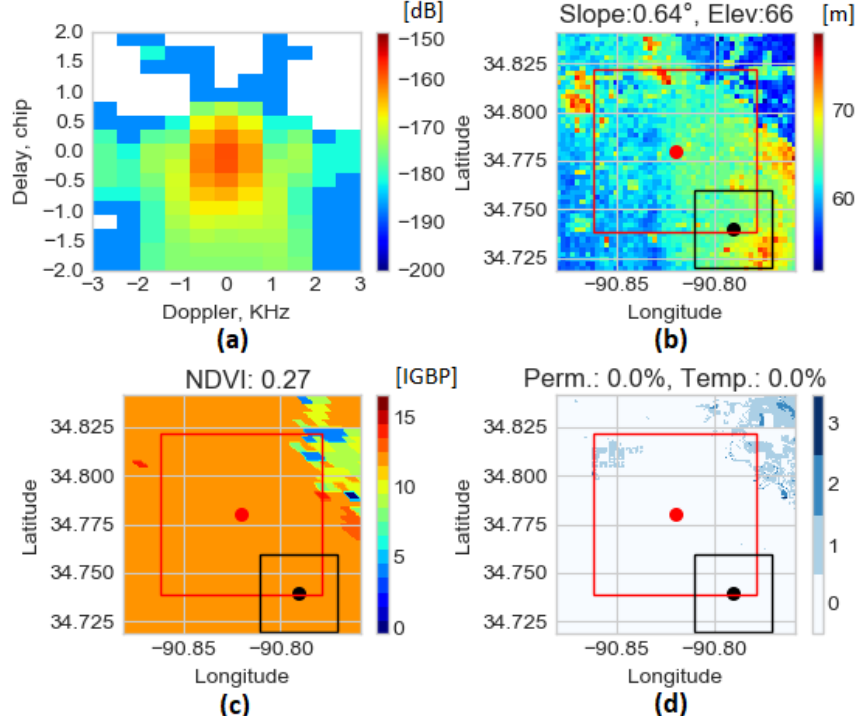
Figure 4. Example grid analysis from a CYGNSS observation over the SCAN site Uapb-Marianna on day-of year (DOY) 71, 2018. The red square is the 9-km grid cell that centers the ISMN site (red dot). The black square is the 4-km grid cells that center the CYGNSS observation SP (black dot) that could fall into anywhere in the 9-km grid. ( a ) DDM power_analog ; ( b ) digital elevation model [m]. Mean slope and elevation values calculated from 4-km grid are also shown; ( c ) IGBP land covers [IGBP]. The color scale for the IGBP land cover is the same as Figure 3. Mean NDVI calculated from the 4-km grid is also shown; ( d ) inland water bodies [Pekel indices [61]]. Permanent and temporary water body percentages within the 4-km grid are also